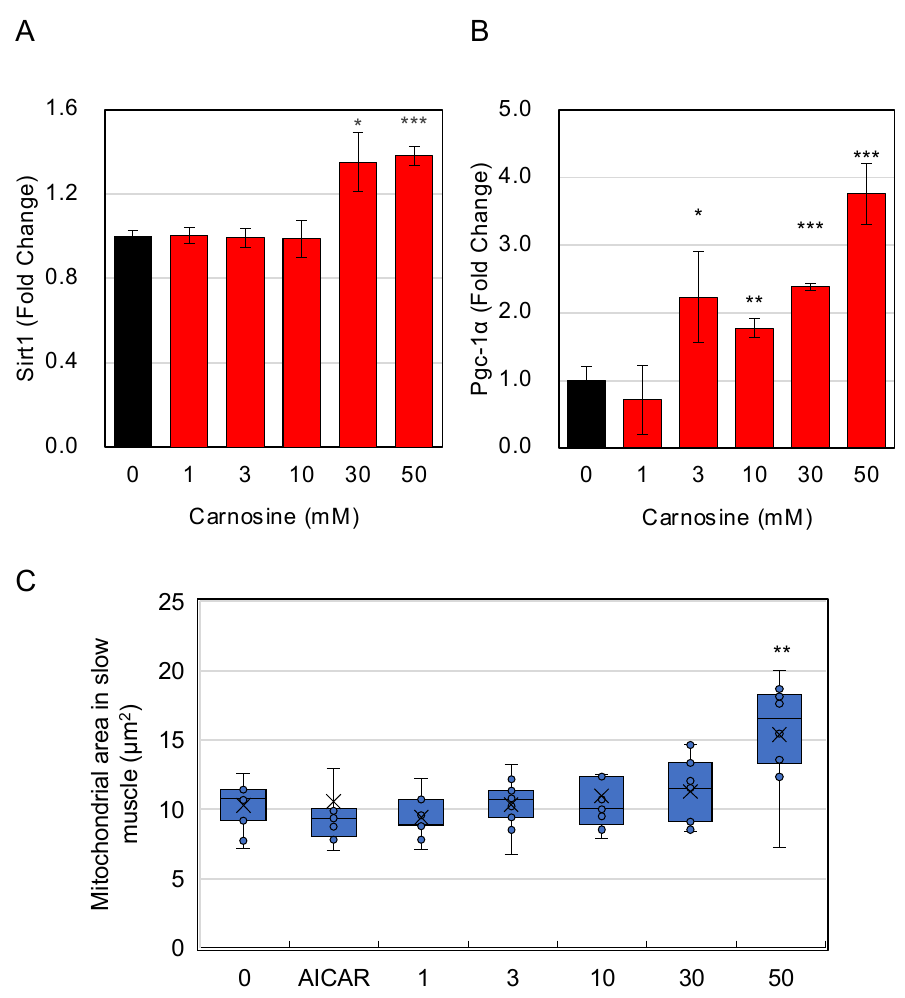
Figure 4. Effects of carnosine on mitochondria in myotube cells. Effects of carnosine on the expression of mitochondria-related genes in myotube cells. C2C12 cells were differentiated in the presence of the indicated amount of carnosine. Expression of mitochondria-related genes of Sirt1 ( A ), and Pgc-1 α ( B ) was quantitatively determined by RT-qPCR. ( C ) The size of mitochondria in myotubes was determined by using IN Cell Analyzer 2200. As a control experiment, C2C12 cells were treated with 250 µ M AICAR, the AMPK activator for 3 days. Multiple comparisons between groups were performed using one-way ANOVA with Tukey’s post-hoc test. Statistical significance was defined as p < 0.05 when compared to control (* p < 0.05; ** p < 0.01; *** p < 0.001).